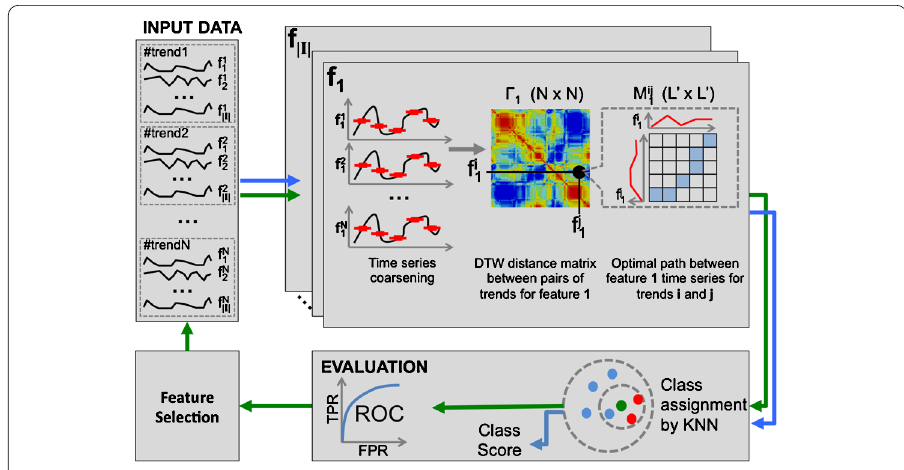
Figure 4 Wrapper method description for KNN-DTW. We present the pipeline of our complete system, including feature selection and model evaluation steps. Input data feed into the system for training (green arrow) and testing (blue arrow)